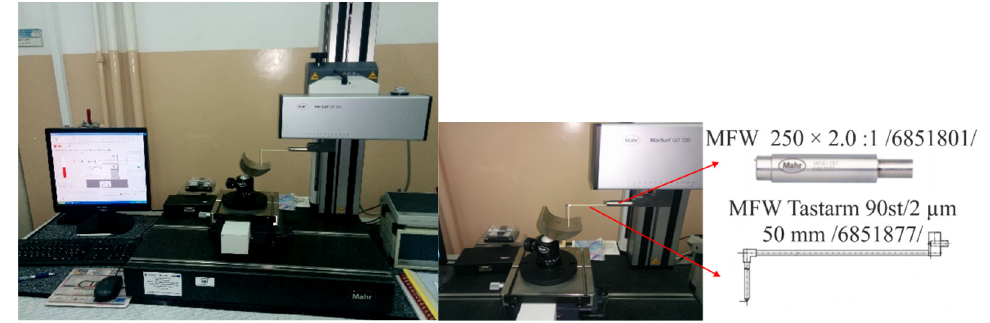
Figure 8. 3D profilograph MarSurf GD 120.